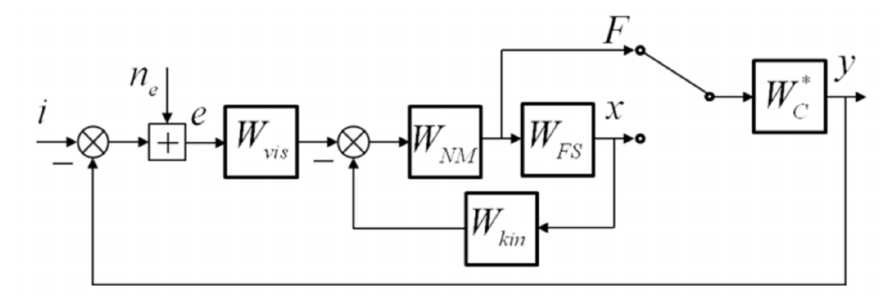
Figure 6. Modified pilot structural